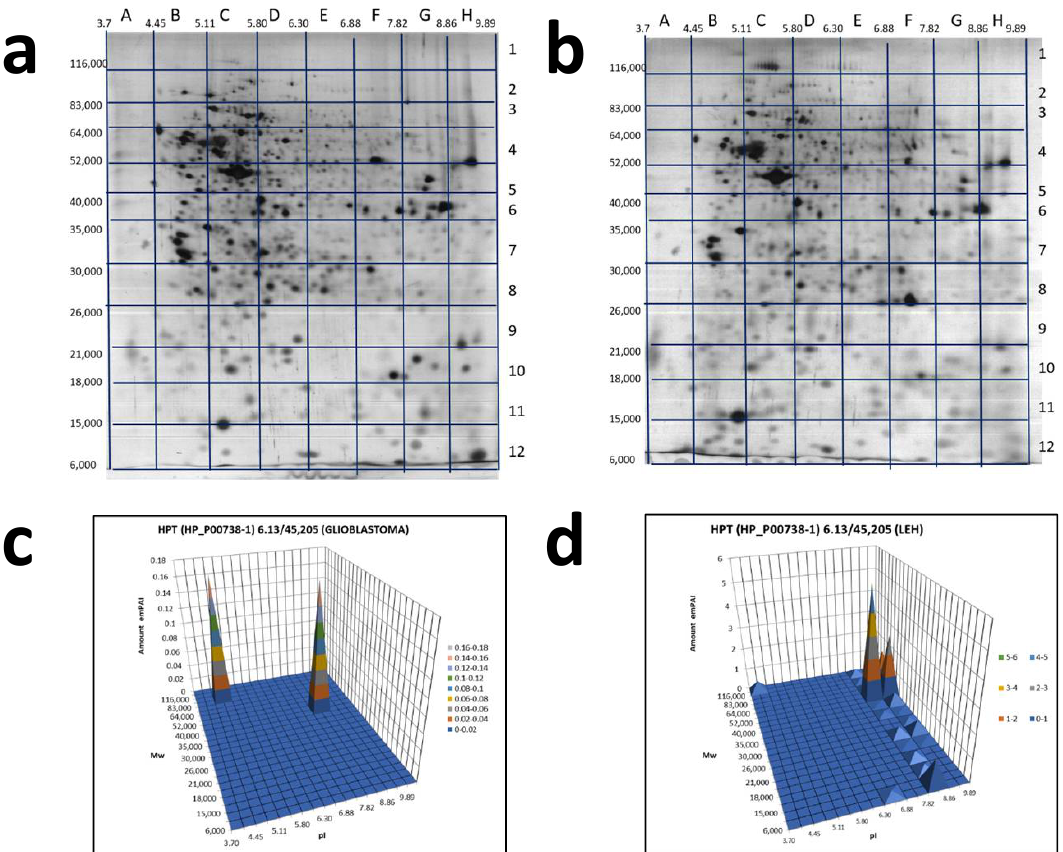
Figure 6. 2DE sectional analysis of Hp proteoforms in cells. Glioblastoma 2DE gel ( a ). LEH 2DE gel ( b ). A 2DE pattern of Hp proteoforms in glioblastoma cells ( c ). A 2DE pattern of Hp proteoforms in LEH cells ( d